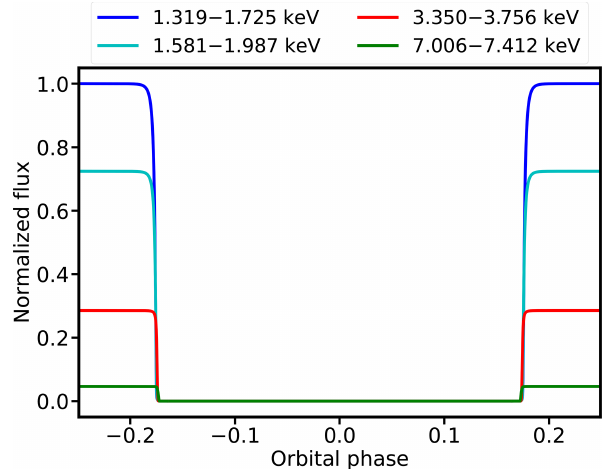
Figure 8. (a) The best-fit model and the data of unattenuated spec- trum for the Crab Nebula from LE. The blue dots with error bars are observation data, and the solid red line is the best-fit model. (b) The residuals ((data − model)/error) of the